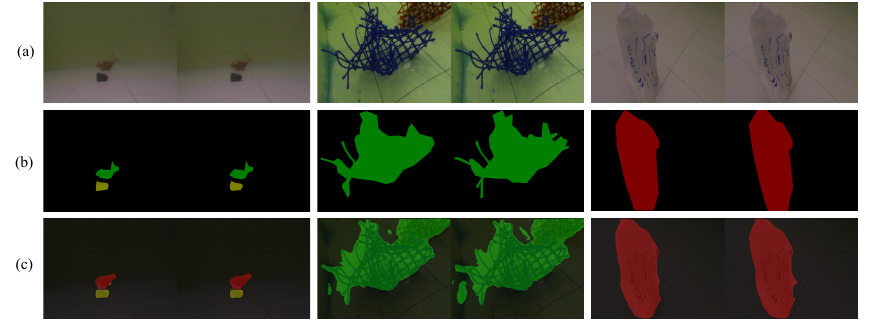
Figure 4. Results of segmentation. ( a ) Input images; ( b ) real masks; ( c ) segmentation